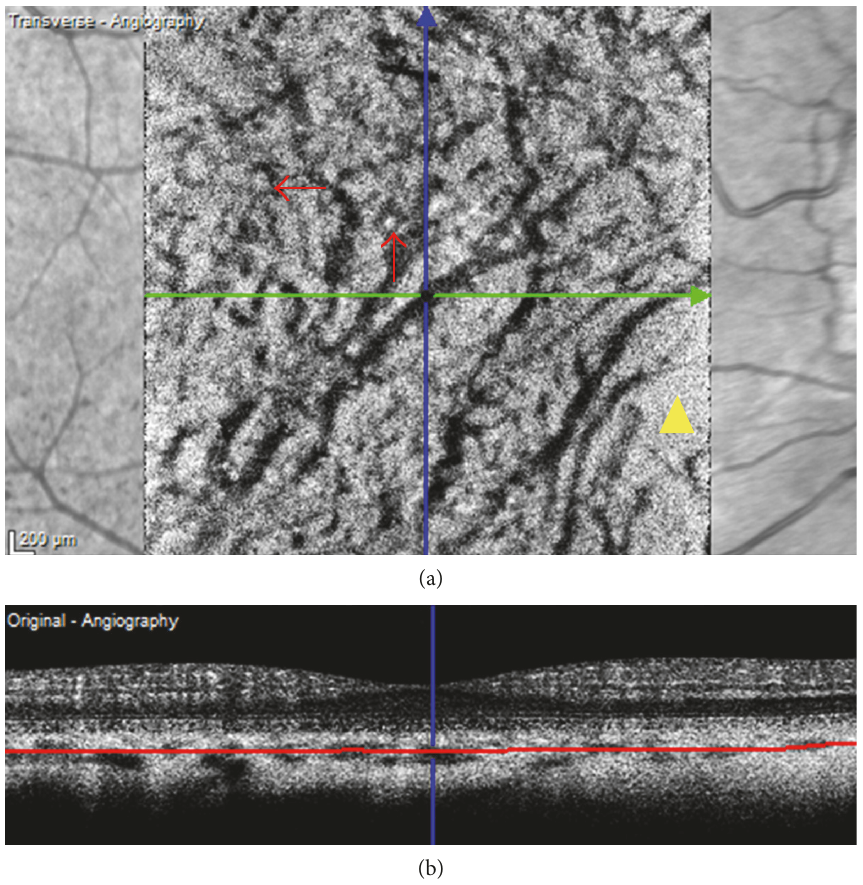
Figure 4: Vascular signals in the middle layer of the choroid. (a) En face OCTA shows cord-like dark vessels (red arrows) attributable to higher blood fl ow and a hyperre fl ective choroidal stroma (yellow arrow head) as a result of fringe washout artefact and stromal decorrelation signal. (b) Cross-sectional OCTA con fi rms a hypointense halo and shows the scanning level. OCTA: optical coherence tomography